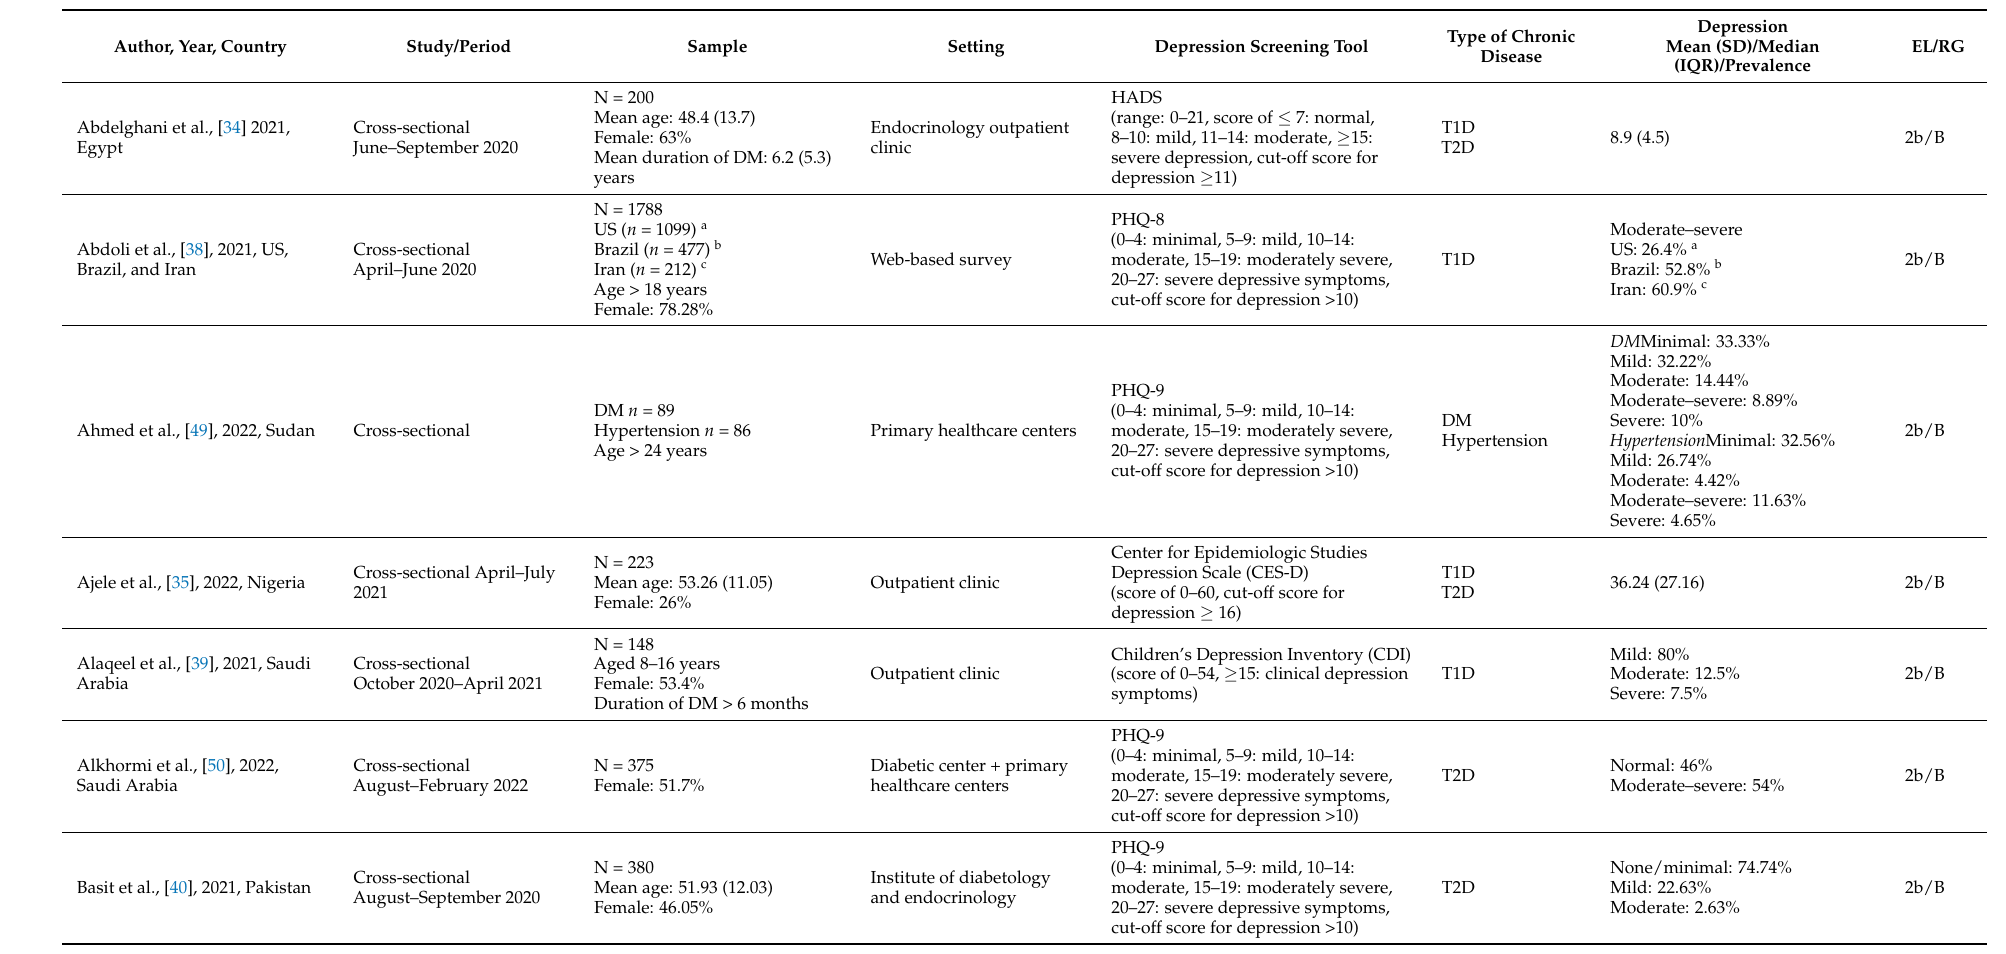
Table 1. Characteristics of the included studies ( n =